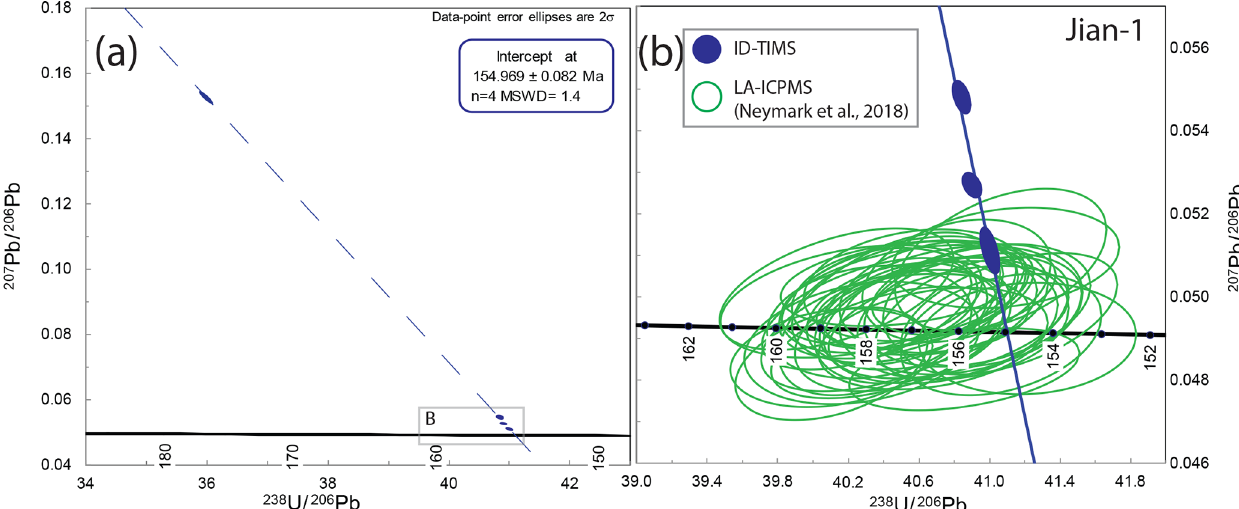
Figure 5. T–W plots of Jian-1. (a) All ID-TIMS U–Pb data and isochron; (b) ID-TIMS data excluding lowest Pb ∗ / Pbc and isochron lower intercept compared with LA-ICP-MS data for Jian-1 cassiterite (Neymark et al., 2018).